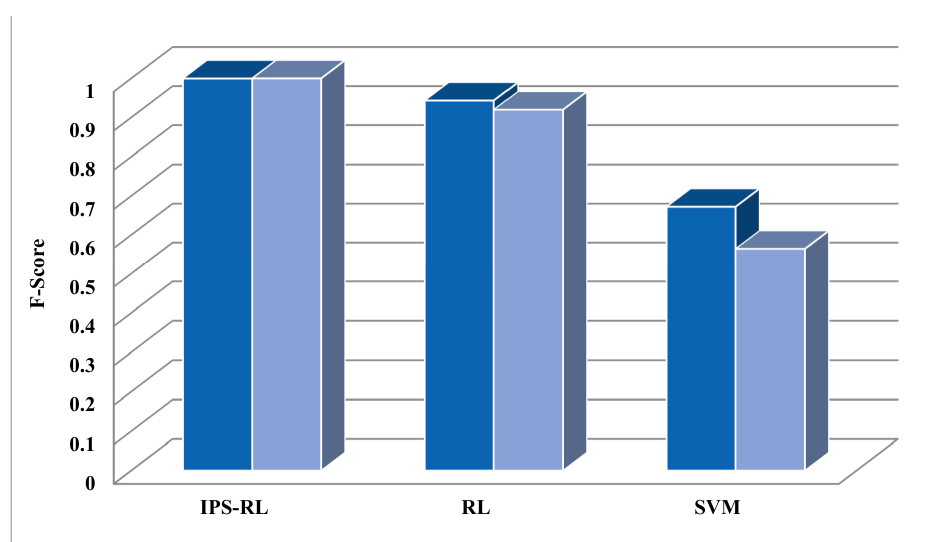
Figure 11. Comparison of algorithms for the convergence algorithm.